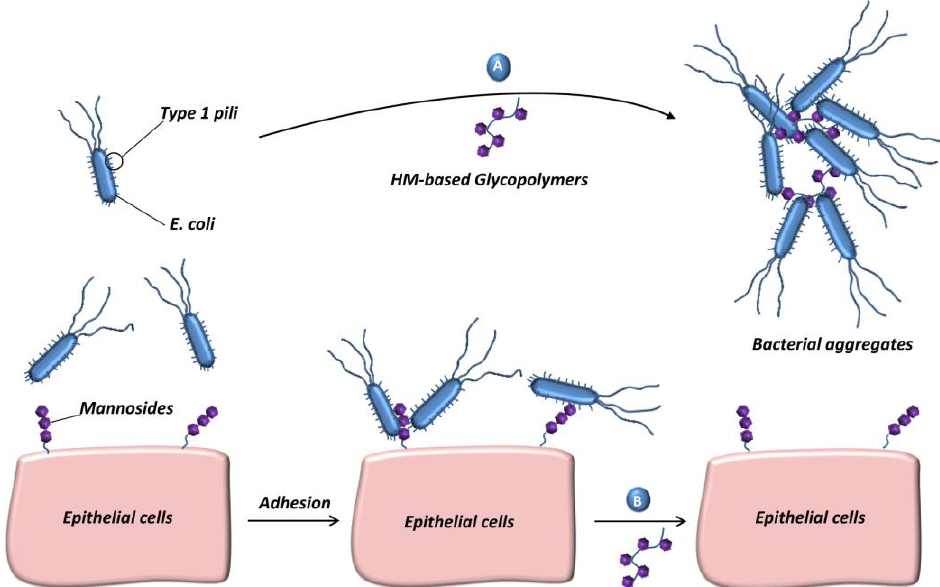
Figure 8. HM − based glycopolymers for inhibiting bacterial infection are shown in figure. ( A ) sequestration of free bacteria in the lumen of the gut and ( B ) disruption of established Escherichia coli − cell interactions. Figure reproduced from ref. [50] with permission.